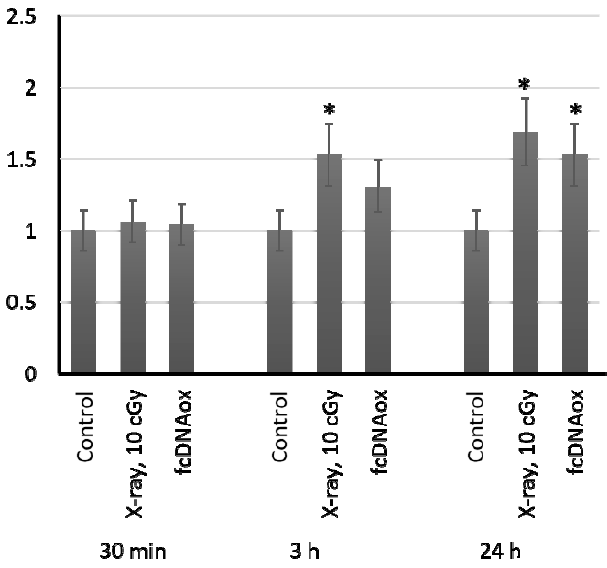
Figure 8. The number of copies of mitochondrial DNA in cells exposed to radiation (10 cGy) or oxidized cfDNA (50 ng/mL) assessed with real-time PCR. Mean values were calculated from seven independent experiments; (*) denotes a significant difference from control experiments, p < 0.01, nonparametric U-test.